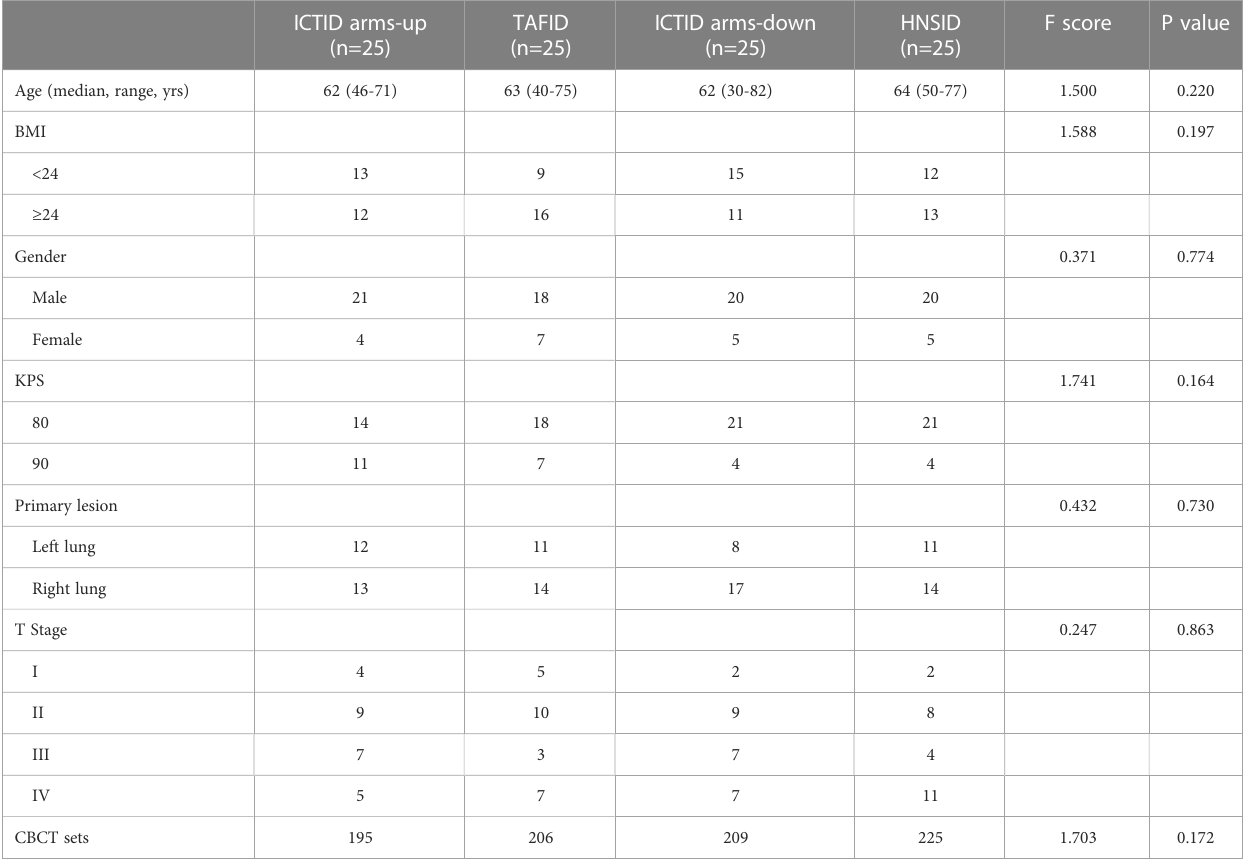
TABLE 1 Baseline characteristics of